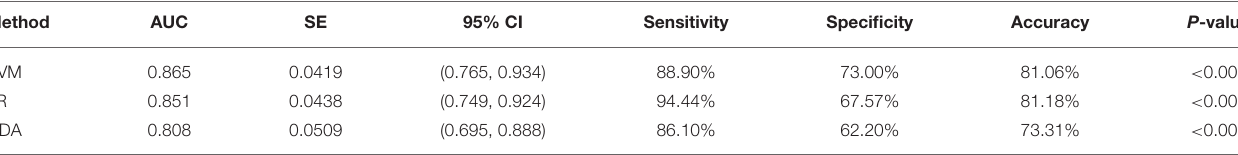
TABLE 4 | ROC analysis for texture classification using machine